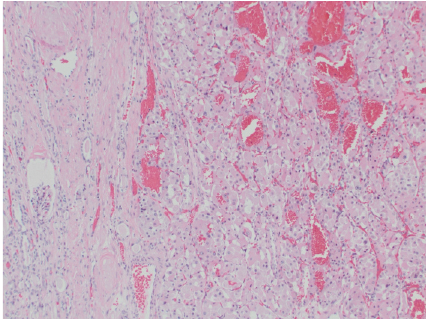
Figure 7: Cross sections of retroperitoneal ancient schwannoma with glistening tan-white